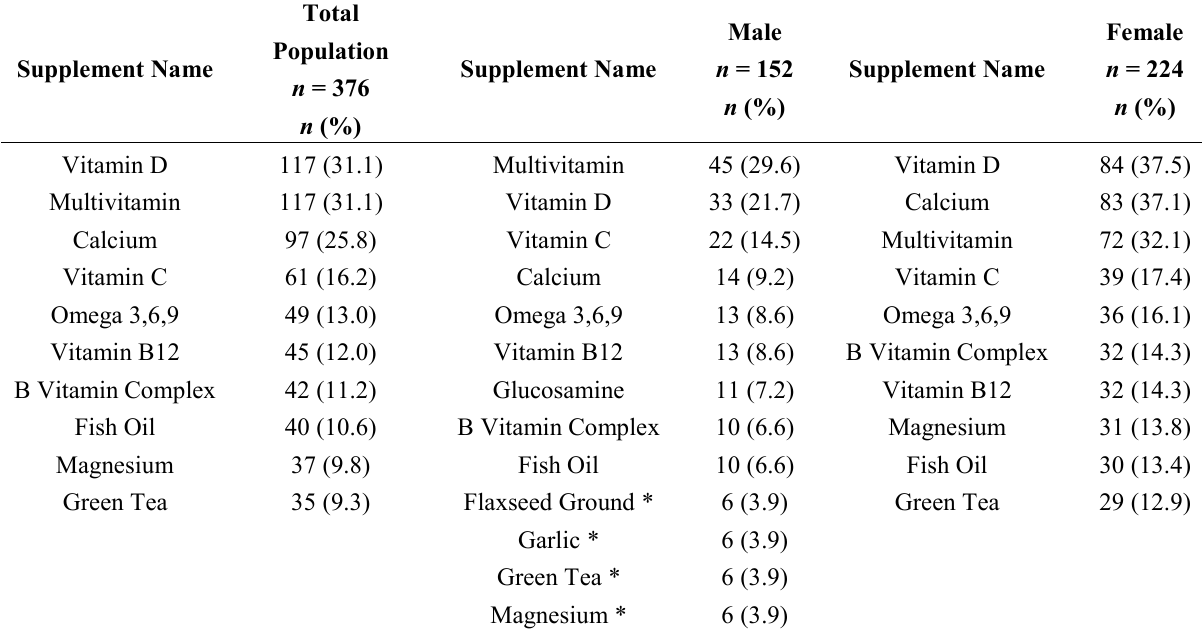
Table 3. 10 Most Frequently Used